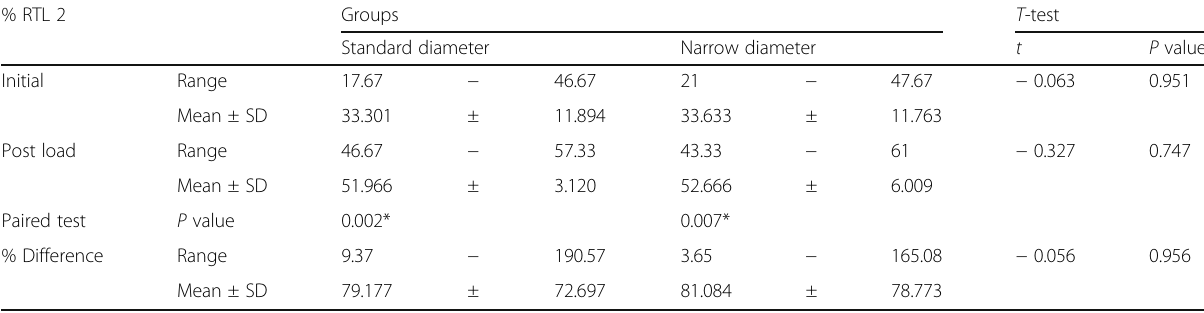
Table 2 Mean ± SD of percentage initial and percentage post load RTL 2 and percentage difference between initial and post load RTL 2 for GI and GII (regarding the screw